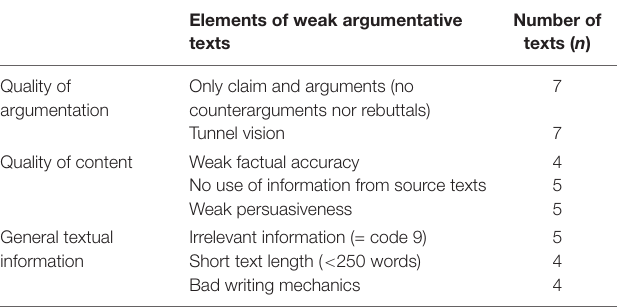
TABLE 11 | Elements of weak argumentative texts.